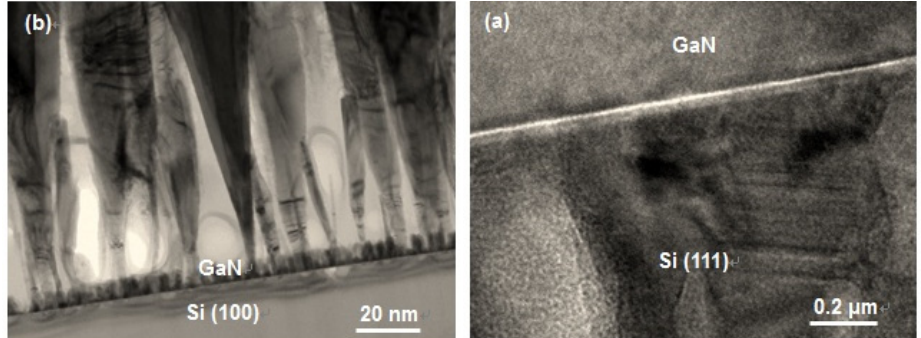
Figure 8. Cross ‐ sectional TEM pictures of GaN films on samples ( a ) C and ( b ) D. Figure 8. Cross-sectional TEM pictures of GaN films on samples ( a ) C and ( b )